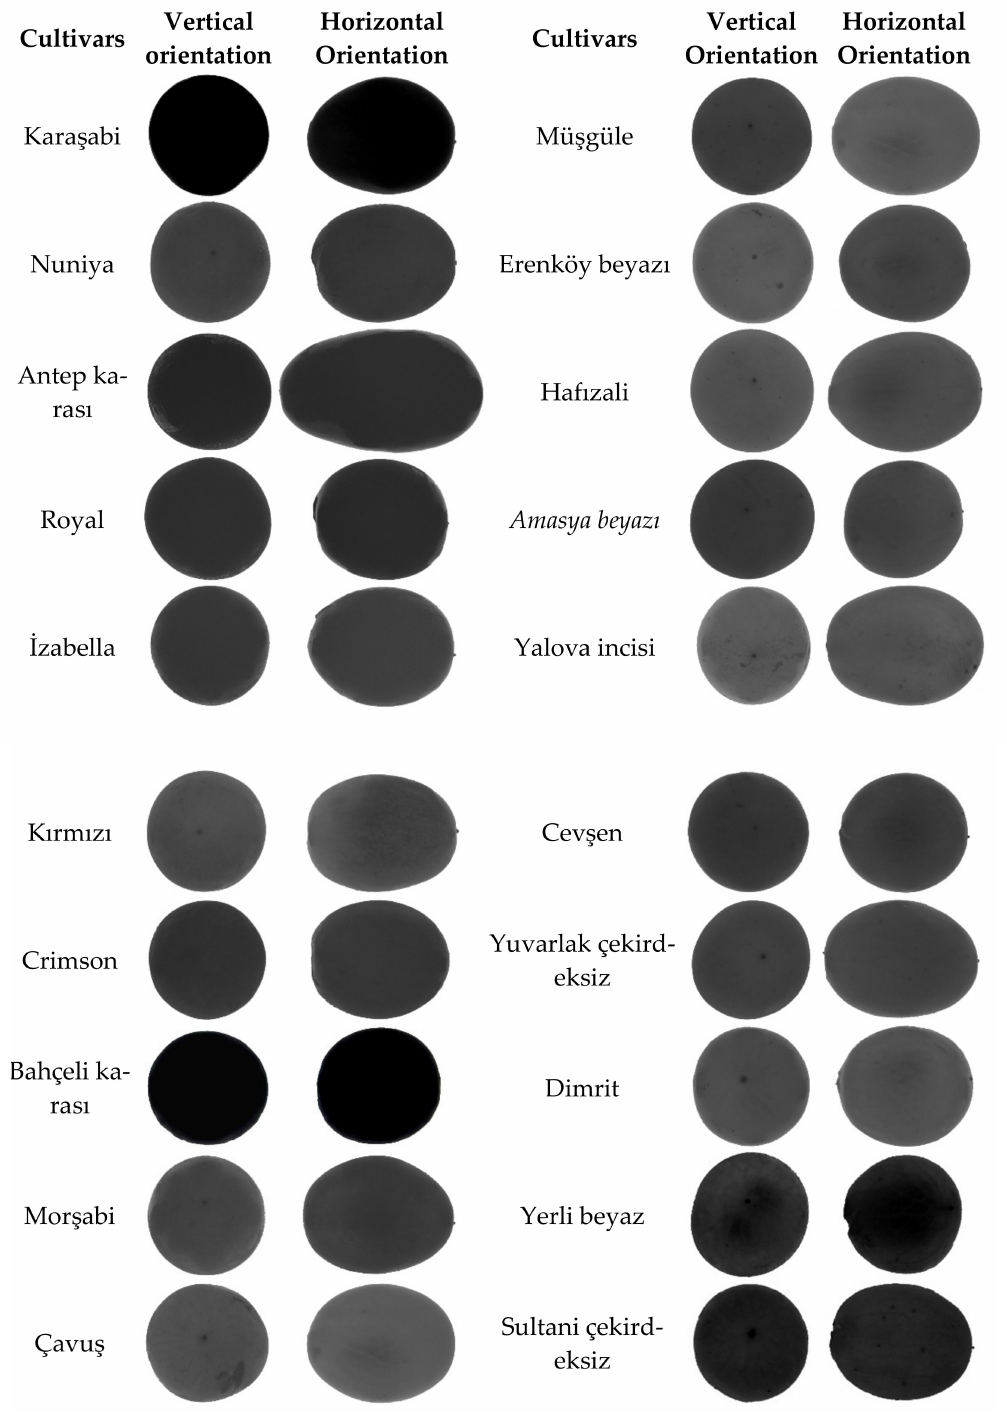
Figure 1. Grapevine